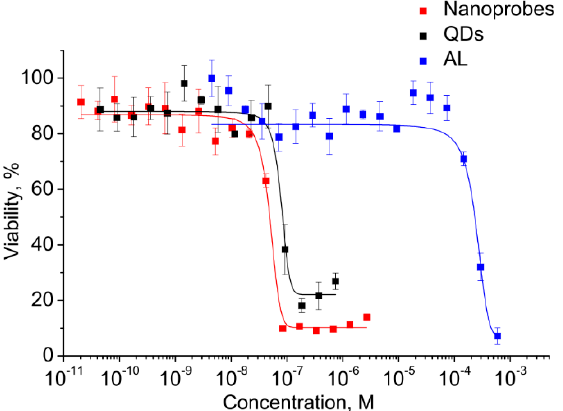
Figure 5. Cell viability in the presence of the conjugate and its components.